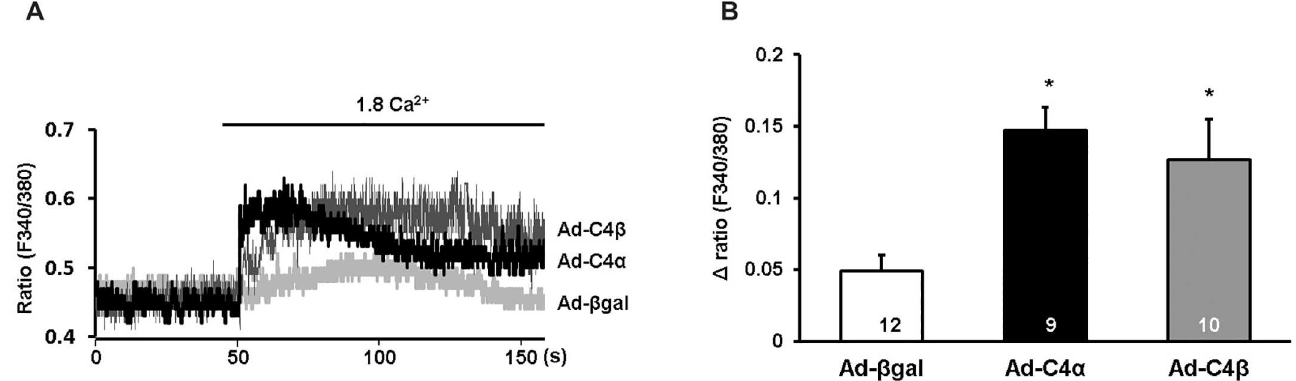
Fig 2. Spontaneous Ca 2+ influx in TRPC4 α and TRPC4 β overexpressing neonatal rat cardiomyocytes. A, Representative Fura-2 Ca 2+ recordingsof neonatalrat cardiomyocytes (NRCs) infected with either Ad- β gal,Ad-TRPC4 α or Ad-TRPC4 β . Cells were perfused with a nominally Ca 2+ -free Tyrode solution including verapamil(10 μ M). After 50 s, Ca 2+ influx was challengedby perfusing the cells with a solutioncontaining1.8 mM Ca 2+ . B, Mean Δ ratio values were calculatedby subtractingthe peak value at 1.8 mM from the baselinevalue at 0 mM Ca 2+ . * P < 0.05vs Ad- β gal.Cells from three different experiments were analyzed.N-numberof cells is indicatedin the